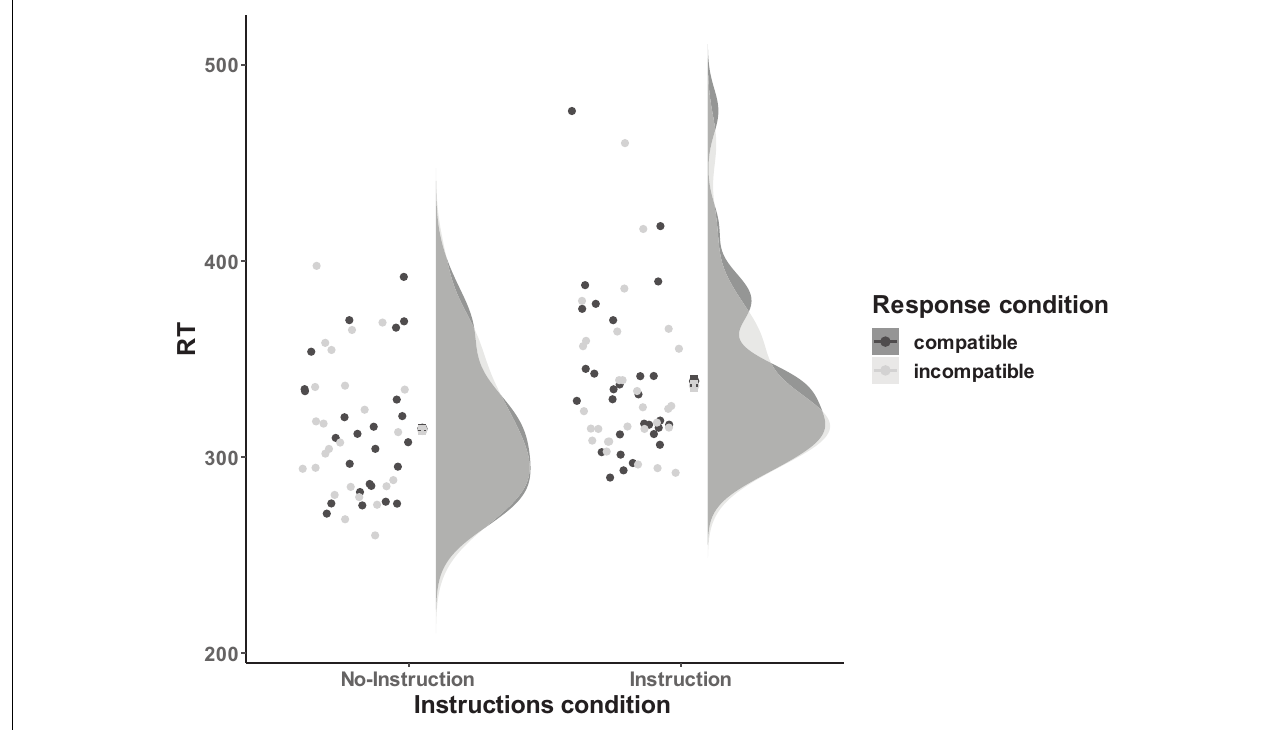
FIGURE 8 | The response performance distribution of all the individual data points for each condition in Experiment 3a. The compatible and incompatible trials are defined depending on the Response-Outcome mapping in the acquisition phase. Error bars represent the 95% confidence